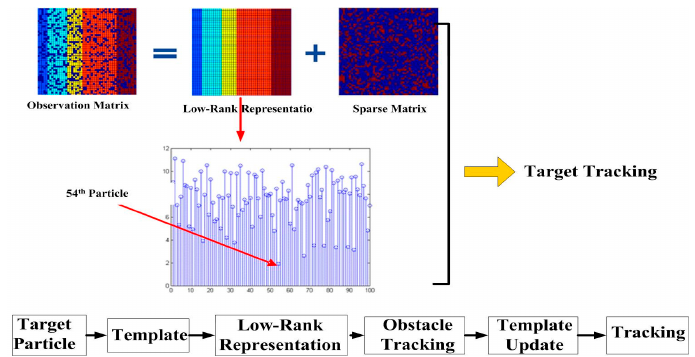
Figure 3. A novel target tracking algorithm in our proposed approach.